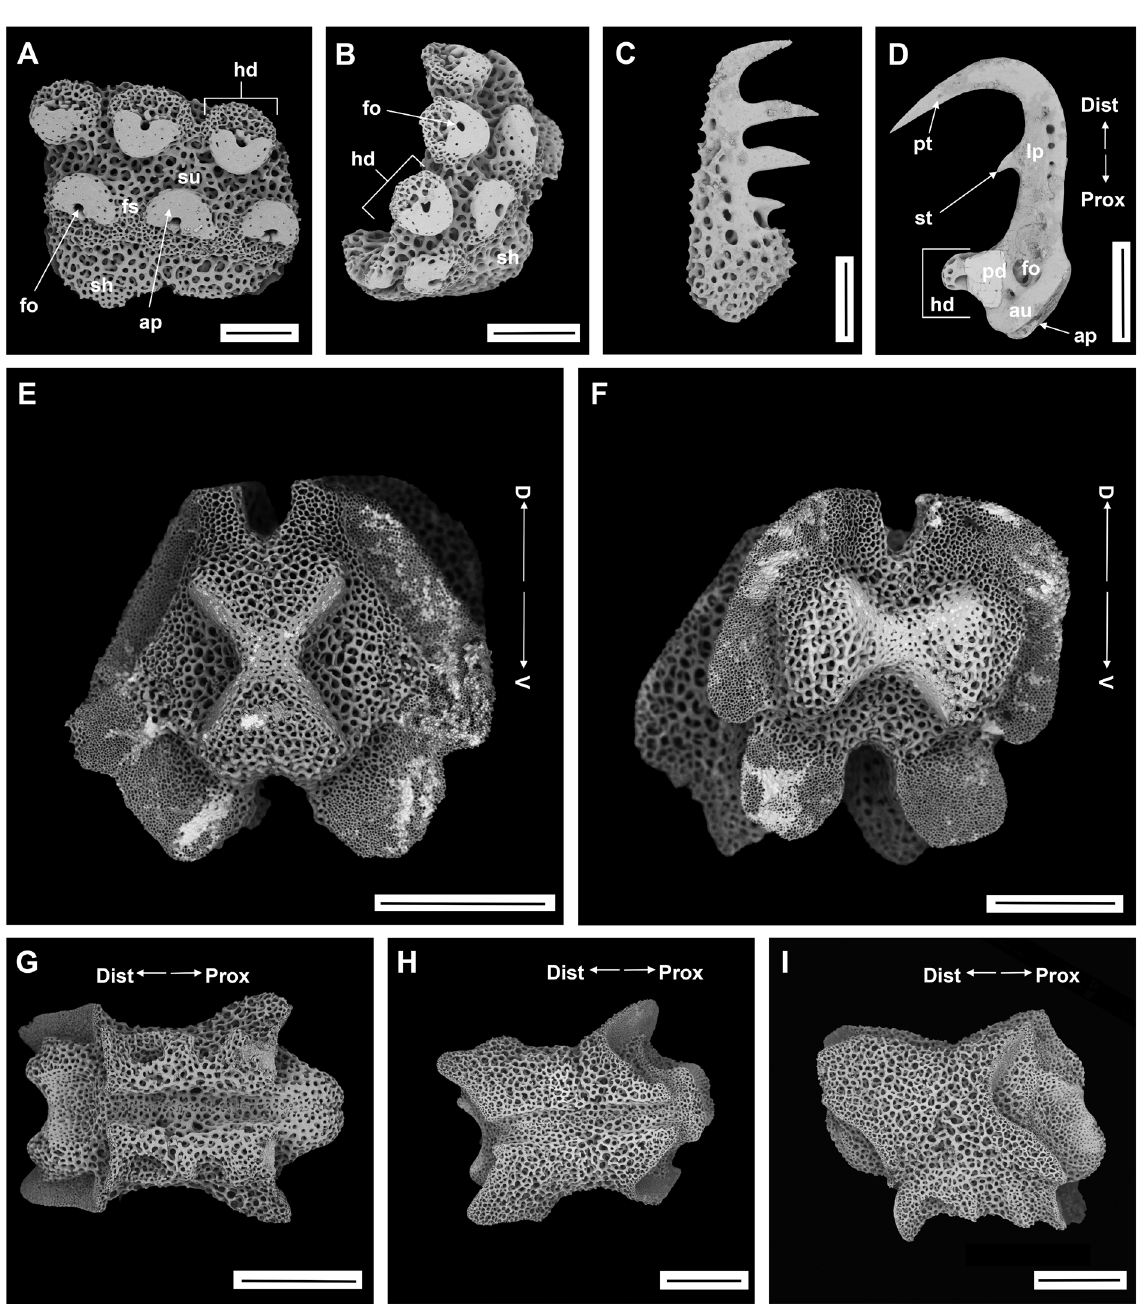
Fig. 10. Gorgonocephalus chilensis novaezelandiae Mortensen, 1924, SEM (IDSSE EEB-SW0005). A . Plan view of the baseplate. B . Distal view of the baseplate. C . Arm spine on proximal lateral plate. D . Pedicellaria on the pedicellarial band. E–I . Vertebrae. E . Proximal view. F . Distal view. G . Ventral view. H . Dorsal view. I . Lateral view. Abbreviations: ap = articular pad of the base; au = auricle; D = dorsal; Dist = distal; fo = foramen of the base; fs = fossa between adjacent tubercles; hd = head of the apophysis; lp = lateral pores of the blade; pd = pedicel of the apophysis; Prox = proximal; pt = primary tooth of the blade; sh = sheath of the baseplate; st = secondary inner tooth; su = sulcus of tubercle head; V = ventral. Scale bars: A–C = 100 µm; D = 20 µm; E, G–I = 300 µm; F = 200